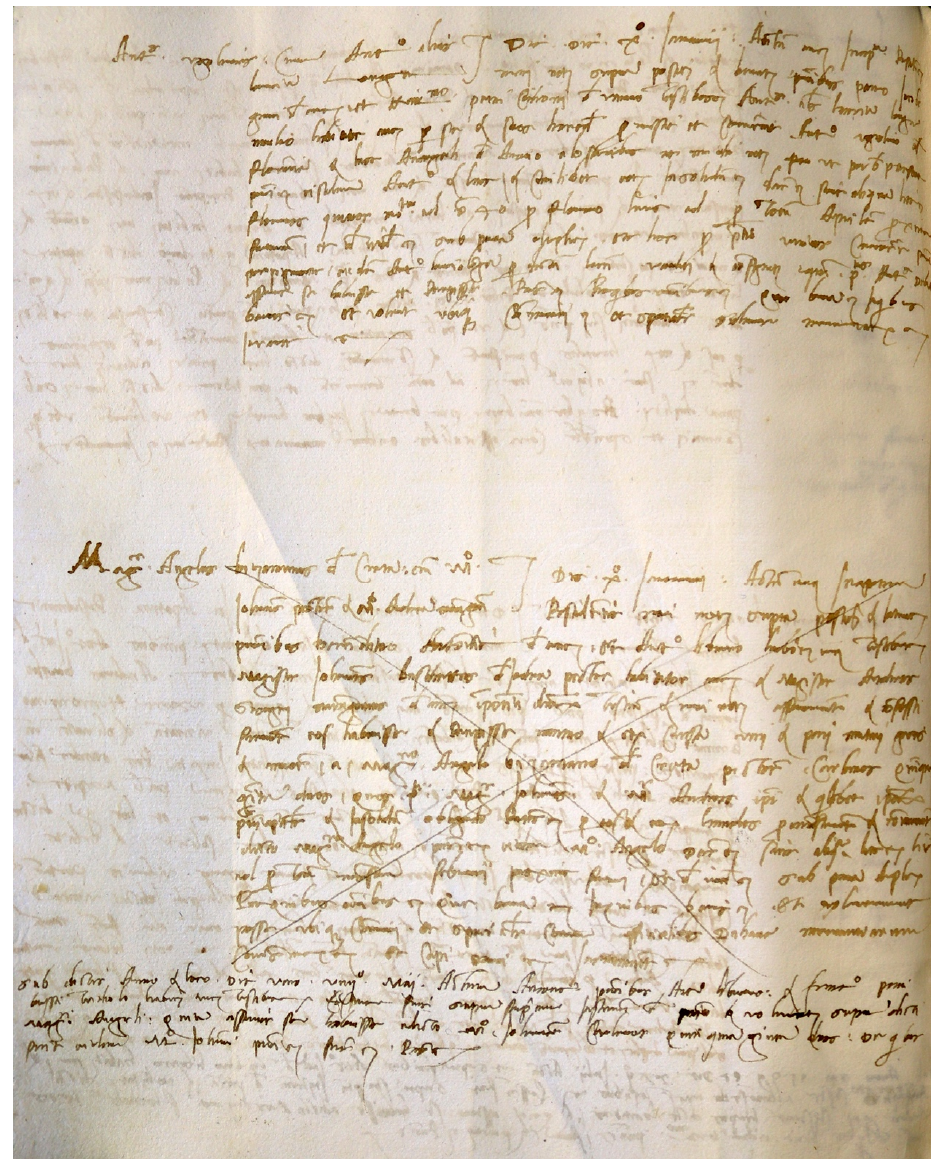
Figure 2. Acts documenting loan agreements between Angelos Bitzamanos, Johannes Boschetus, and Andrea di Giorgio (ASA, ANA, vol. 165, notary Troilo Leoni, 1508, fol. 55 v ). Author’s photo; Reproduced with permission.